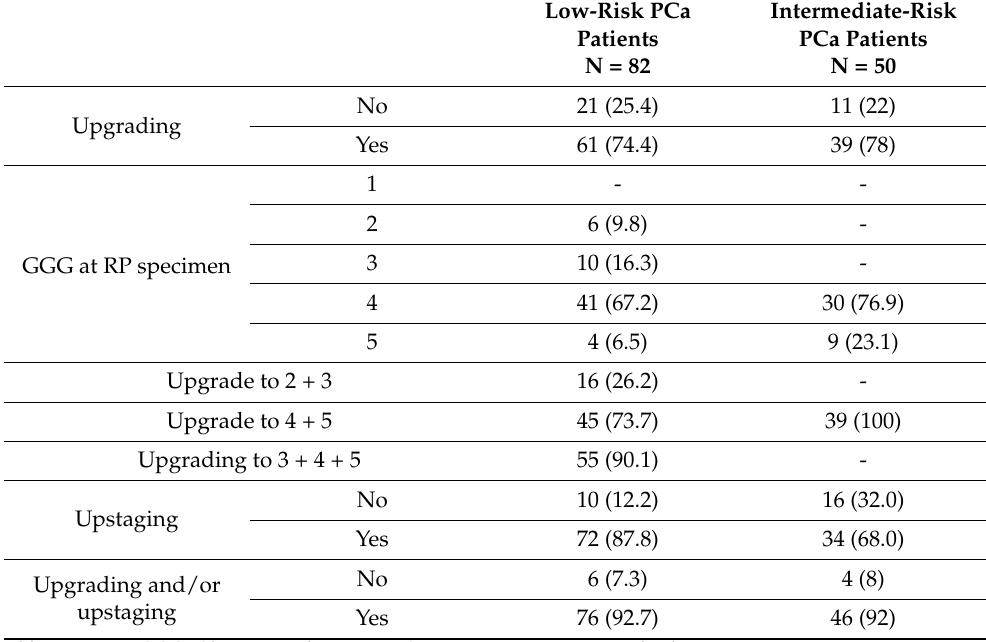
Table 3. Rates of upgrading, upstaging and upgrading and/or upstaging of 132 PCa patients who underwent RARP, stratified according to D’Amico risk